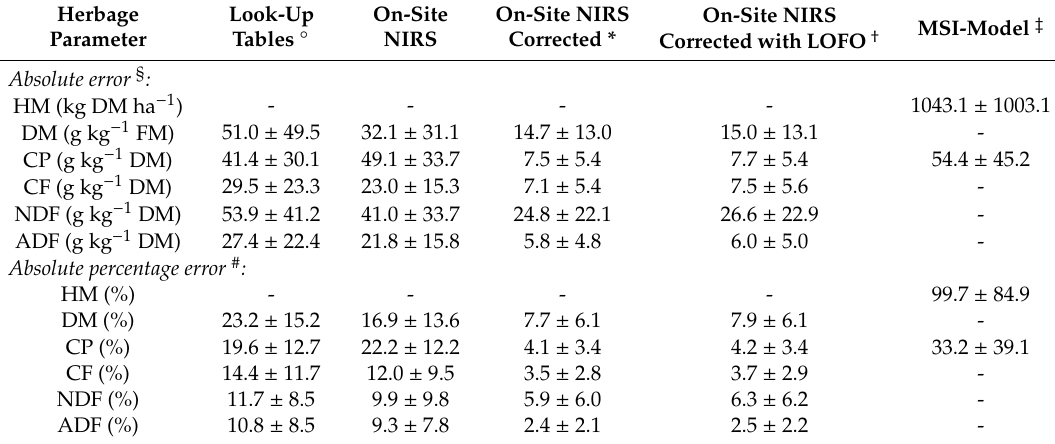
Table 4. Disagreement (mean ± standard deviation) of Look-up Tables, On-site NIRS, and MSI-model with the reference methods (oven-drying and laboratory NIRS; n =